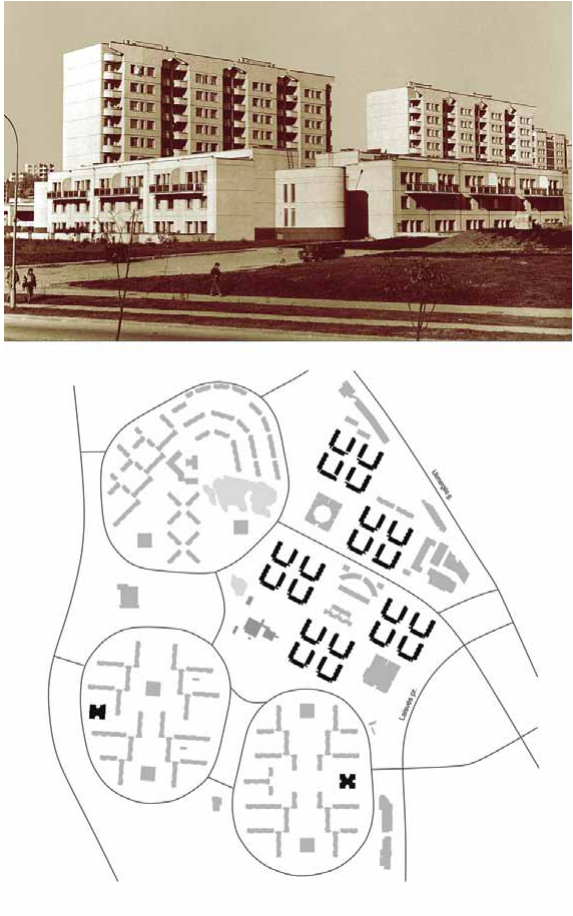
Fig. 8. Monolithic apartment complex in residential district IV of